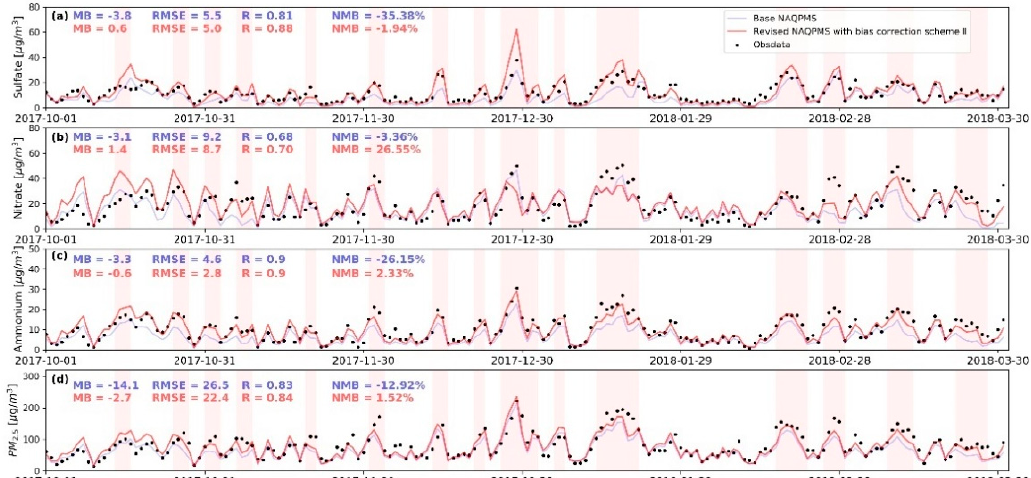
Figure 6. Comparison of the simulated and observed (black solid cycles) daily sulfate ( a ), nitrate ( b ), ammonium ( c ), and PM 2.5 , ( d ) concentrations averaged over the 28 monitoring sites in North China Plain from 1 October 2017 to 31 March 2018. The red background represents the polluted period. The black dots correspond to the observations, and the red and blue lines indicate the simulations of the base run and the run with bias correction scheme II, respectively.